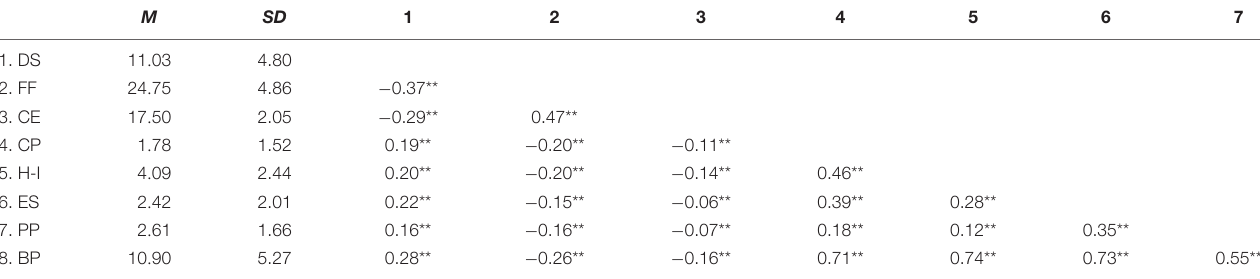
TABLE 1 | Means, SD s, and correlations among study variables ( N = 1,450).